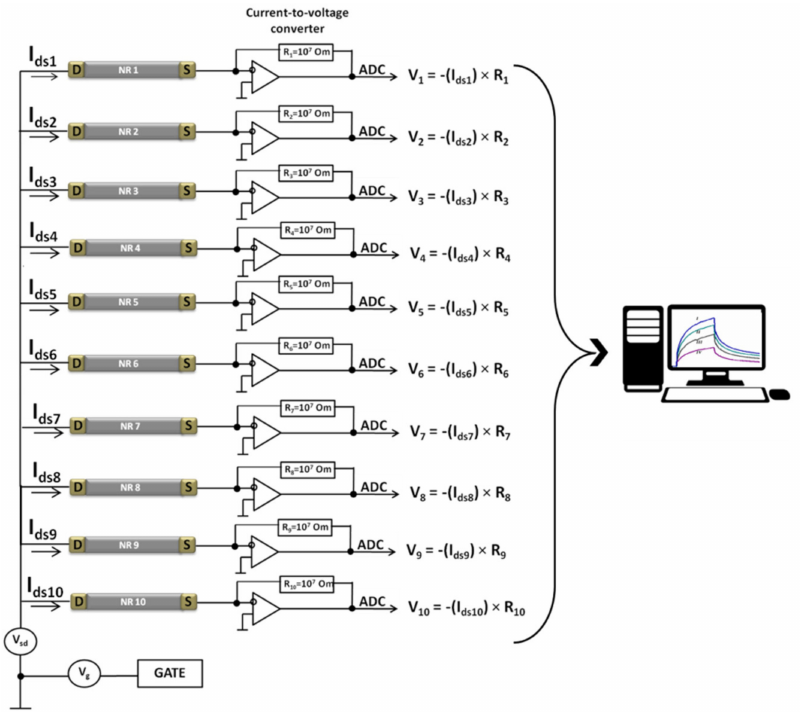
Figure 3. Electronic measurement circuit of the NR biosensor. Abbreviations: ADC, analog-to-digital converter; S, source; D, drain; V ds , drain–source voltage; V g , gate voltage; I ds , drain–source current; R, resistor; NR,